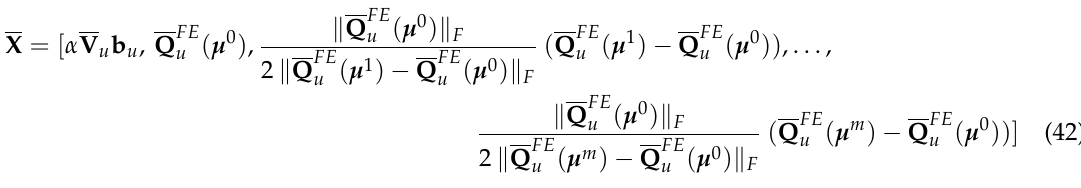
Figure 10. Magnitude of the displacement (